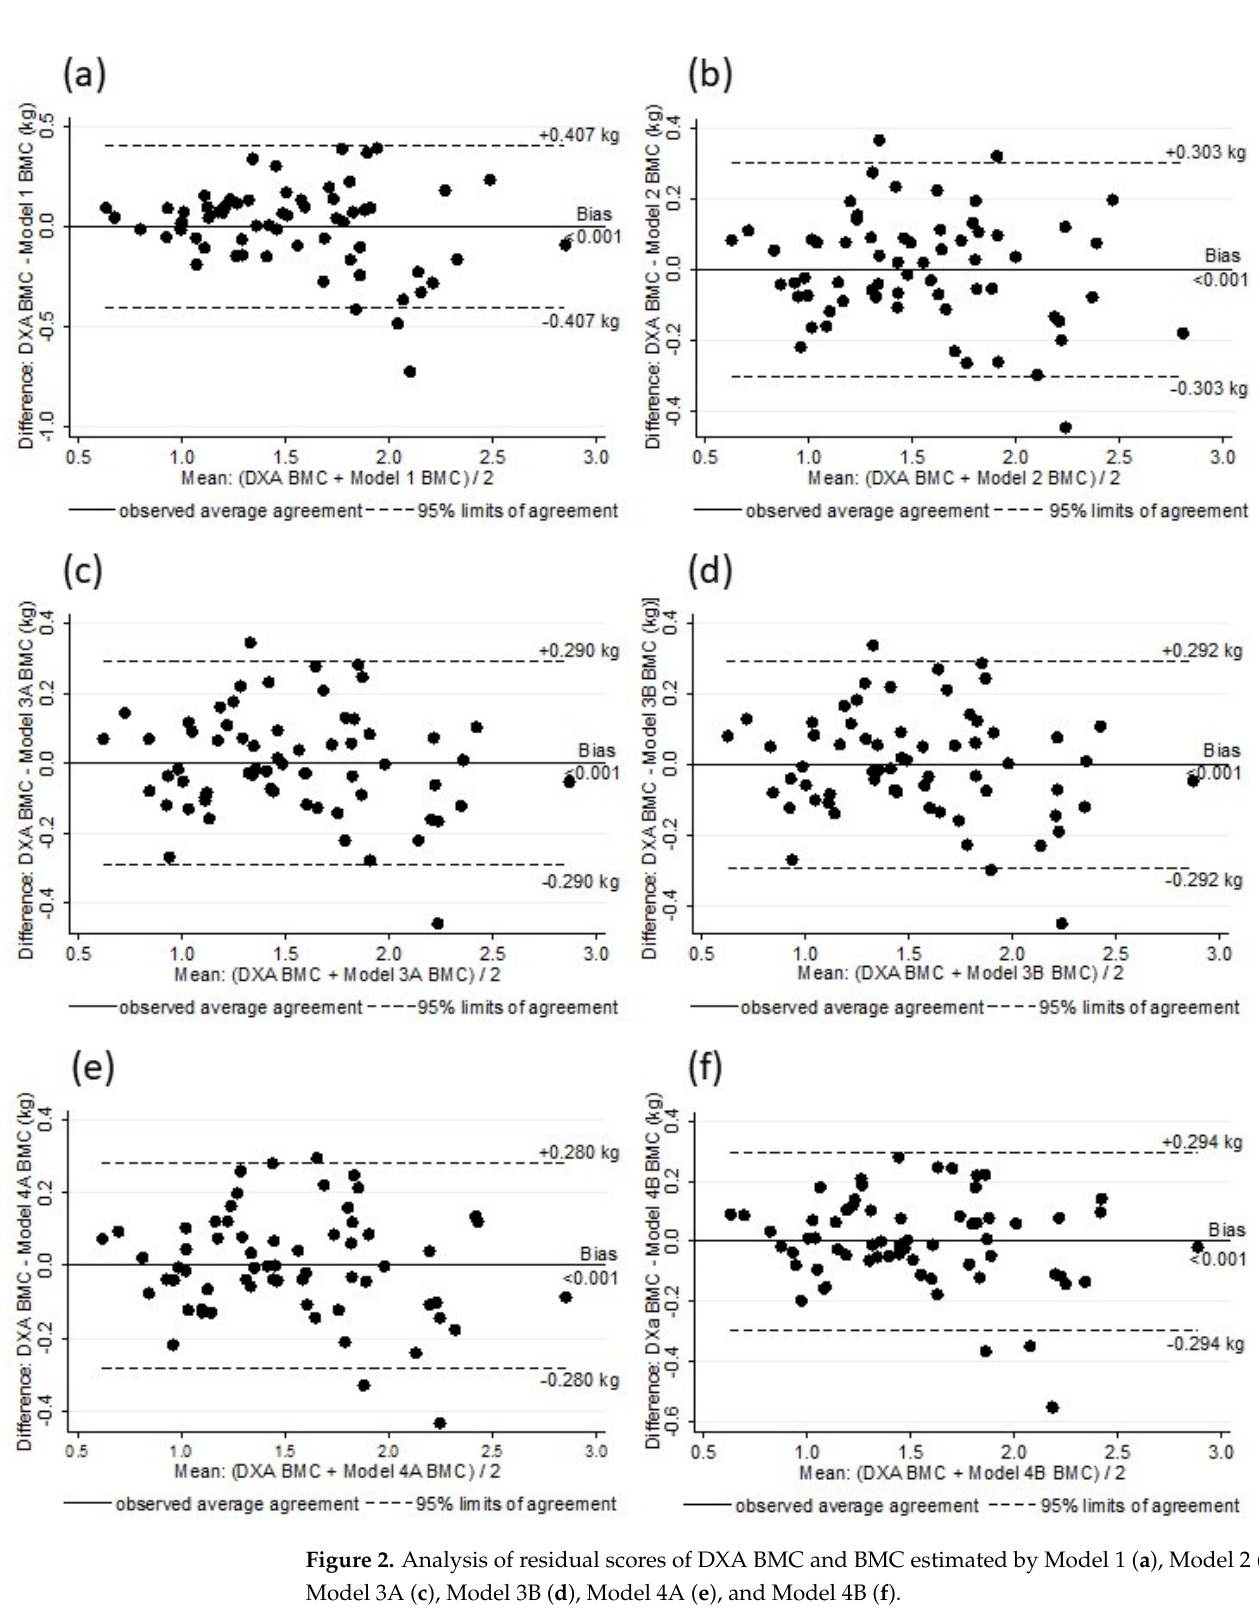
Figure 2. Analysis of residual scores of DXA BMC and BMC estimated by Model 1 ( a ), Model 2 ( b ), Model 3A ( c ), Model 3B ( d ), Model 4A ( e ), and Model 4B ( f ).